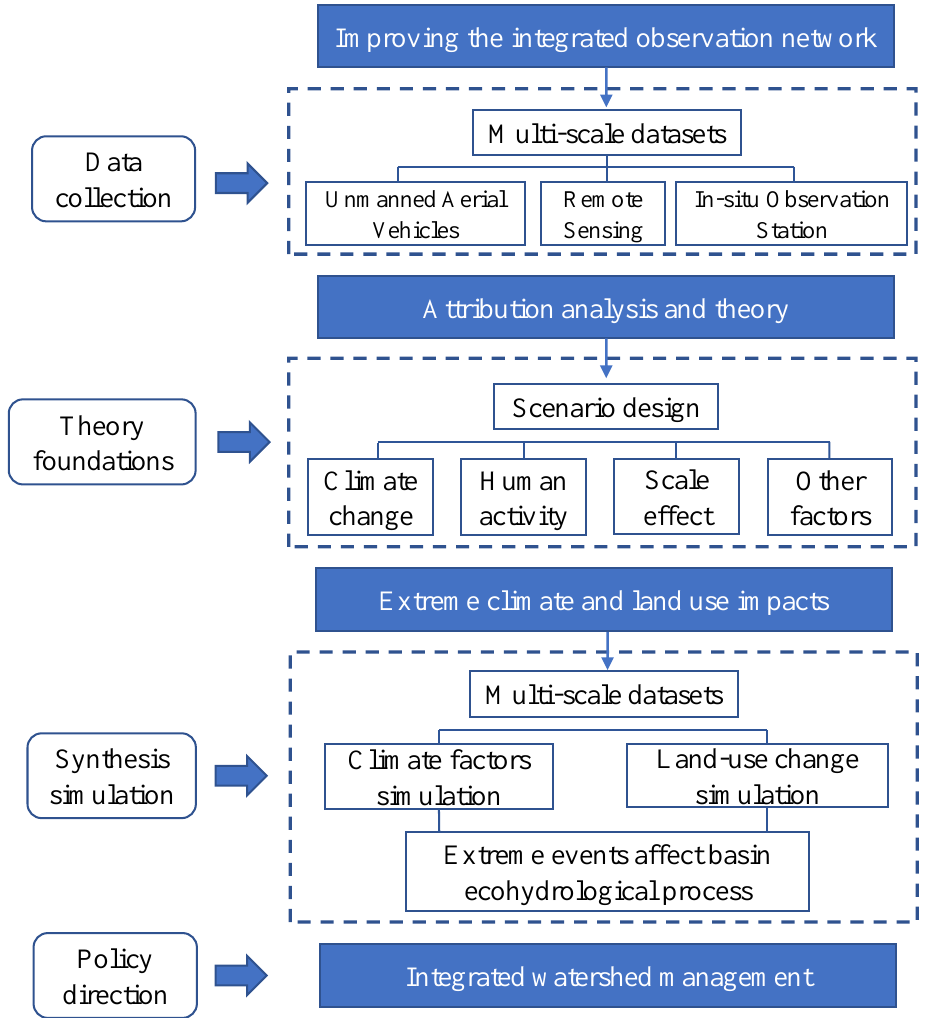
Figure 5. A framework for integrated watershed management in a dramatically changing environment.